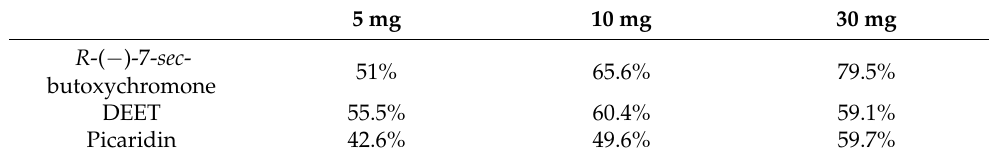
Table 17. Comparison of repellent effects of R -( − )-7- sec -butoxychromone ( 14 ), DEET, and